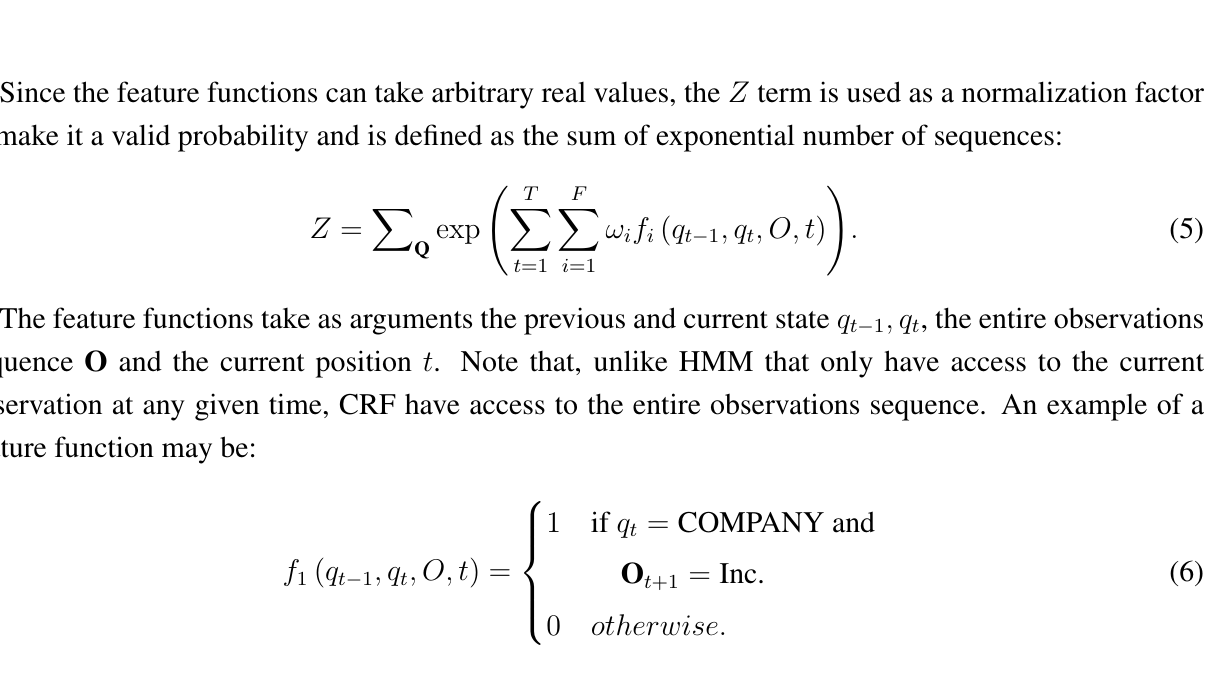
but the CRF has t